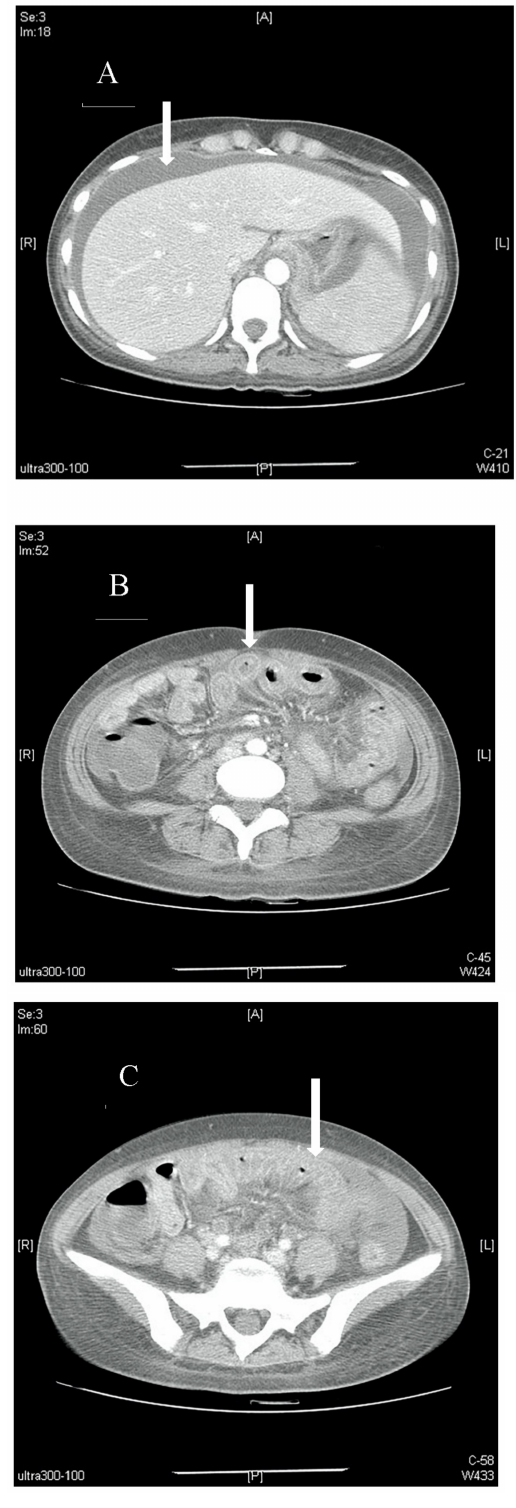
Figure 2. ( A ). Axial view of a contrast-enhanced abdominal CT scan showing massive ascites (arrow) with no signs of occlusion or filling defect in major vessels. ( B ). Axial view of a contrast-enhanced abdominal CT scan showing bowel-wall thickening and enhancement, which is also known as target sign (arrow). ( C ). Axial view of a contrast-enhanced abdominal CT scan showing edematous ileum wall with engorgement of mesenteric vessels and increased number of visible vessels, which is also known as comb sign